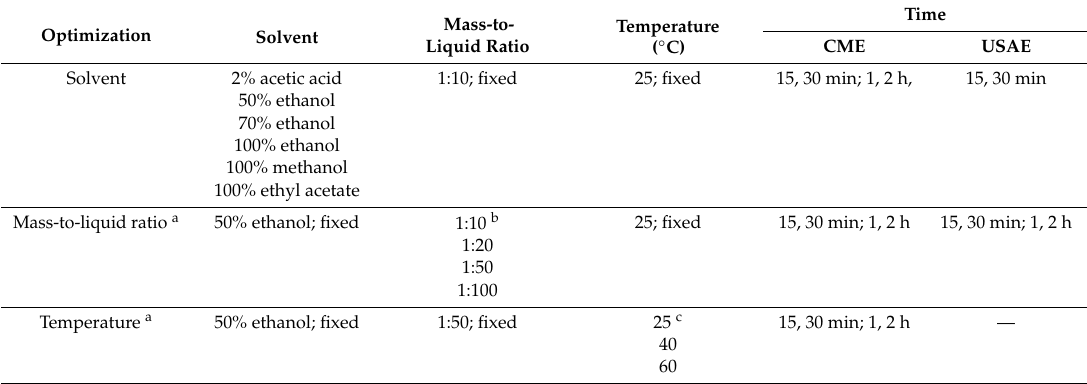
Table 1. Optimization of the conditions used for the primary and secondary extractions. See Section 3.3. for further